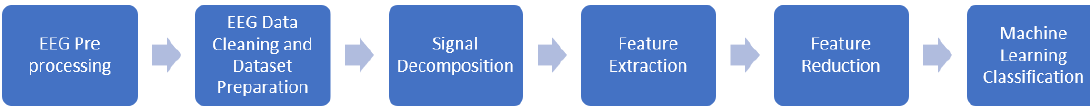
Figure 2. The process of epileptic seizure data classification.